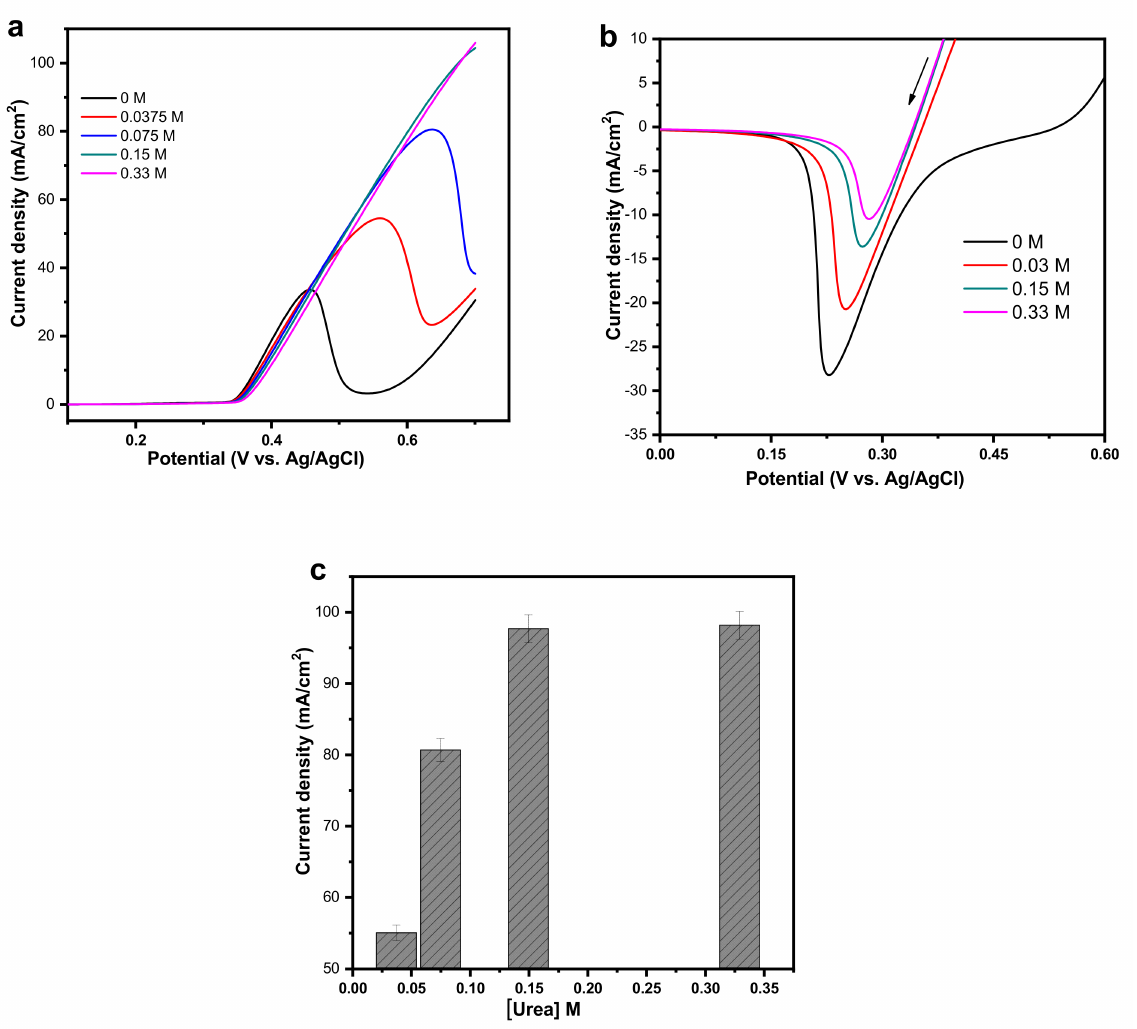
Figure 7. Cyclic voltammetry at 50 mV/s for Ni(OH) 2 -DMSO/CP catalyst in 1.0 M KOH and at various urea concentrations: ( a ) forward scan/( b ) backward scan, and ( c ) displays the plot for the different urea concentrations against the anodic oxidation